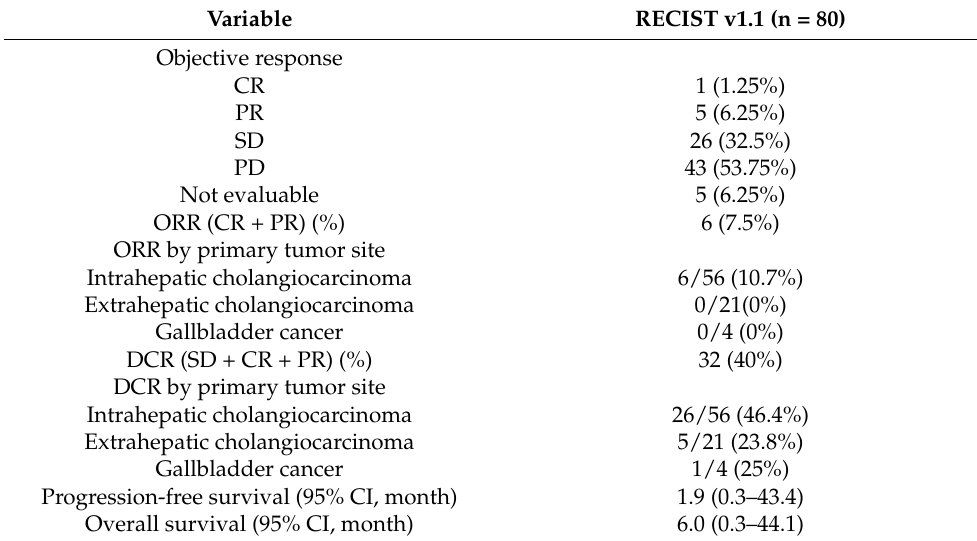
Table 2. Clinical outcomes of patients.